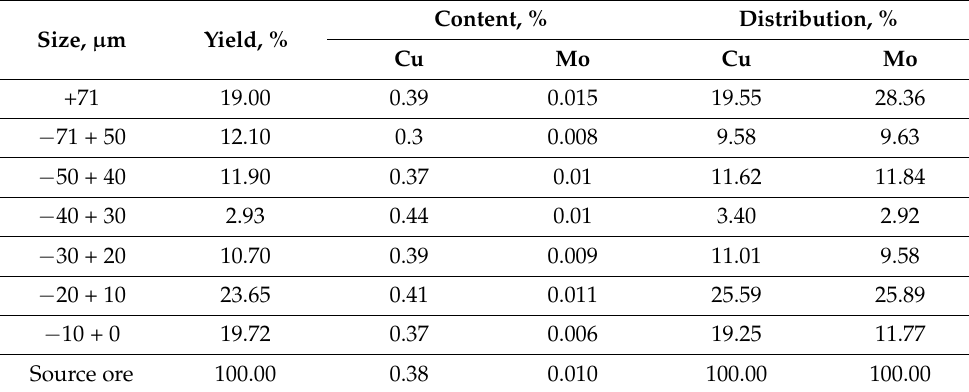
Figure 4. Dispersion composition of finely crushed ore (90%—74 µ m). Table 2. Distribution of copper and molybdenum by size